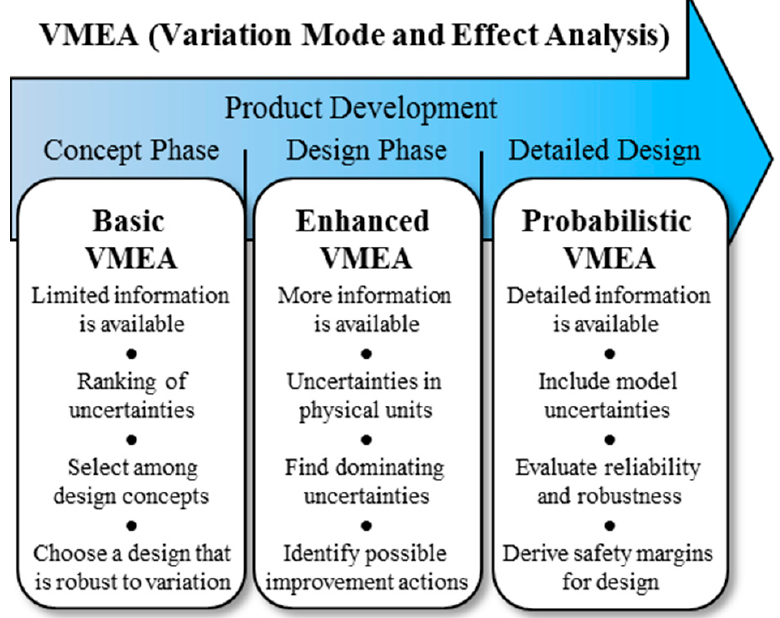
Figure 4. VMEA in different design stages.